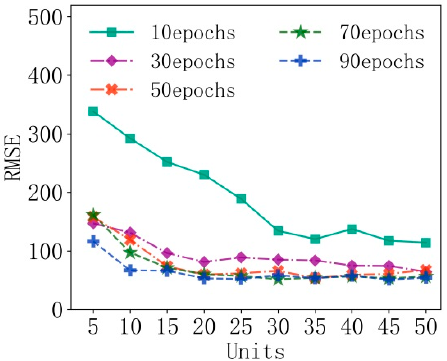
Figure 12. Schematic diagram of prediction error changing trend with epochs and units.